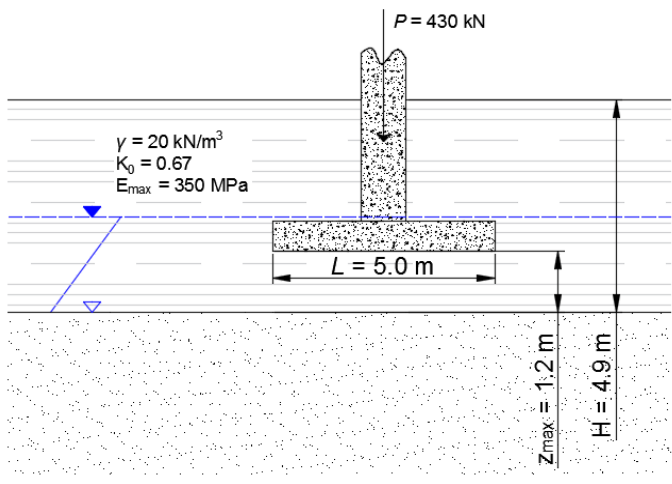
Figure B2. Schema of the approximate method for distribution of vertical stress due to surface load.